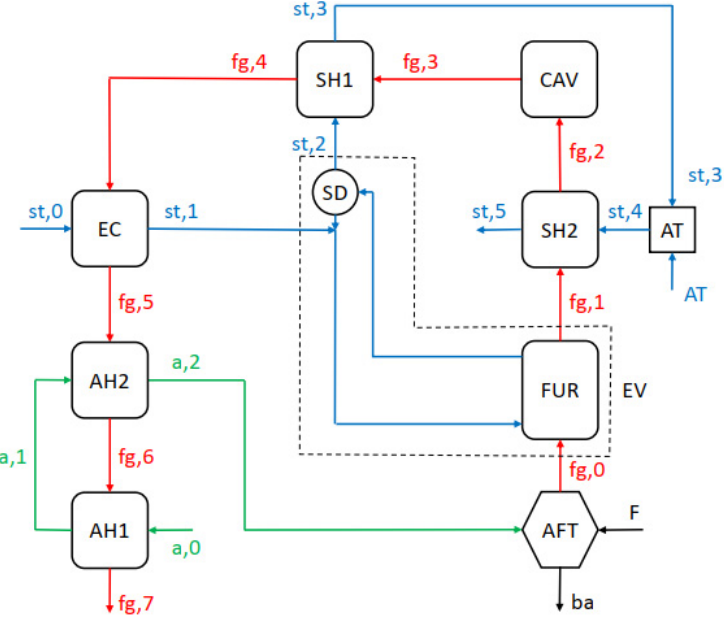
Figure 1. Integrated PFD of a representative simplified boiler layout. AFT—adiabatic flame temperature, FUR—furnace, SH—superheater, AT—attemperator, CAV—cavity, EC—economiser, AH—air heater, SD—steam drum, ba—bottom ash.